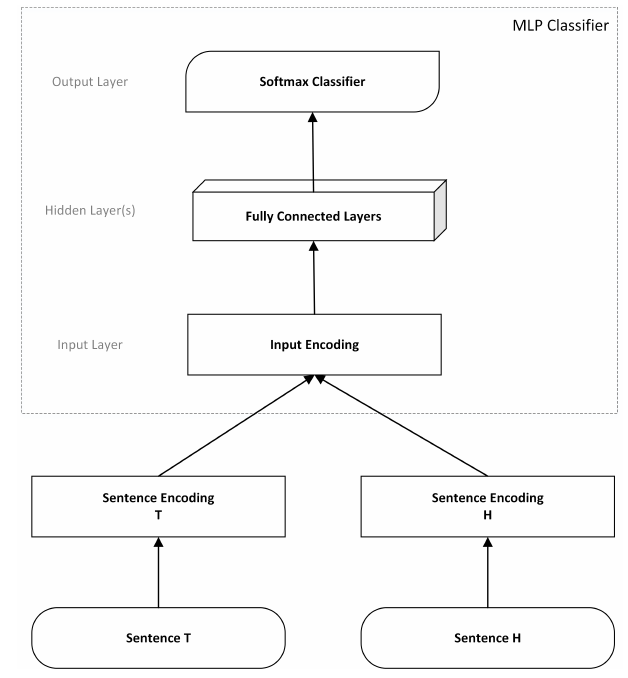
Figure 1. Generic architecture of a neural network system for